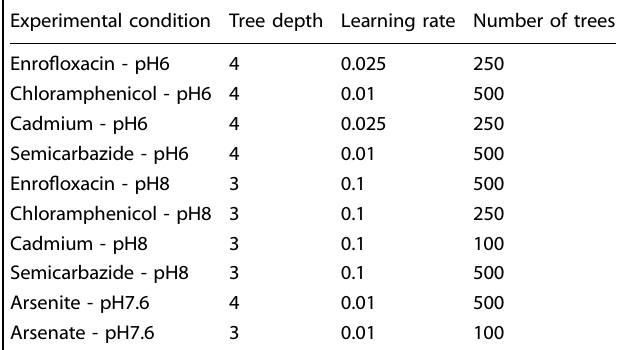
Table 5. Hyperparameters selected for gradient-boosted decision